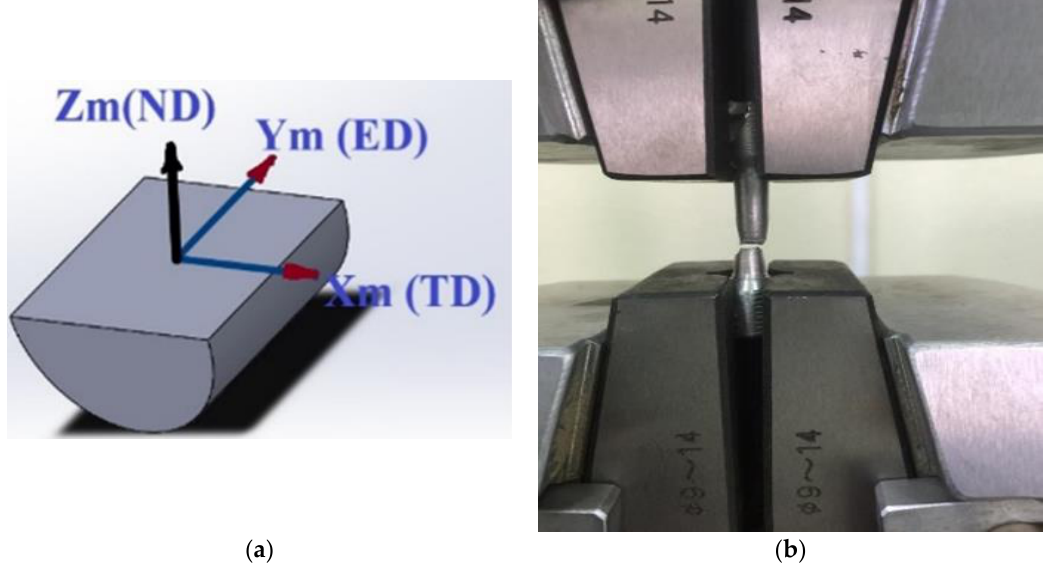
Figure 5. ( a ) Representation of the references axes with respect to the ECAPed sample [25], ( b ) The ECAPed AA2011 sample during tensile test.